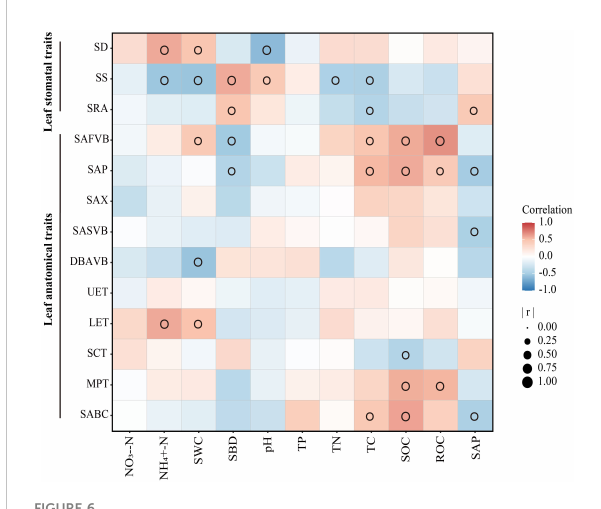
FIGURE 6 Relationship between soil and leaf traits of moso bamboo. Soil